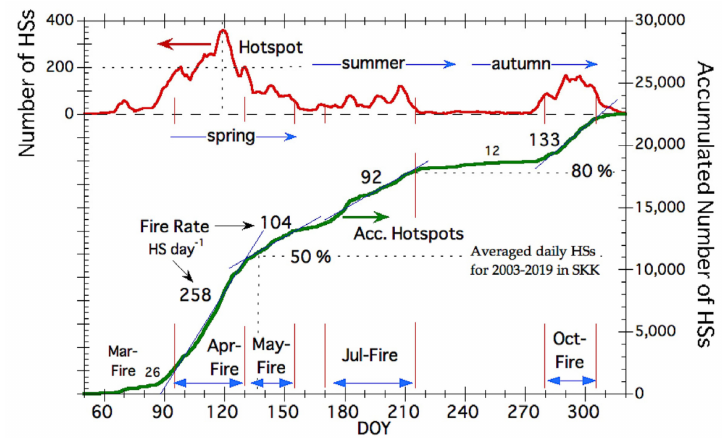
Figure 4. The 17-year average fire tendency in thee